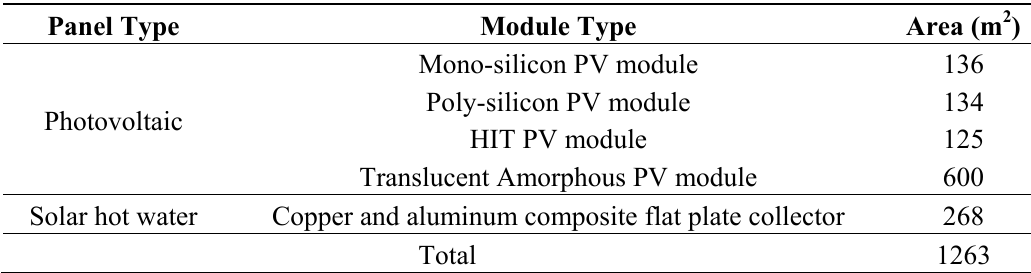
Table 2. Solar panel types and areas at the